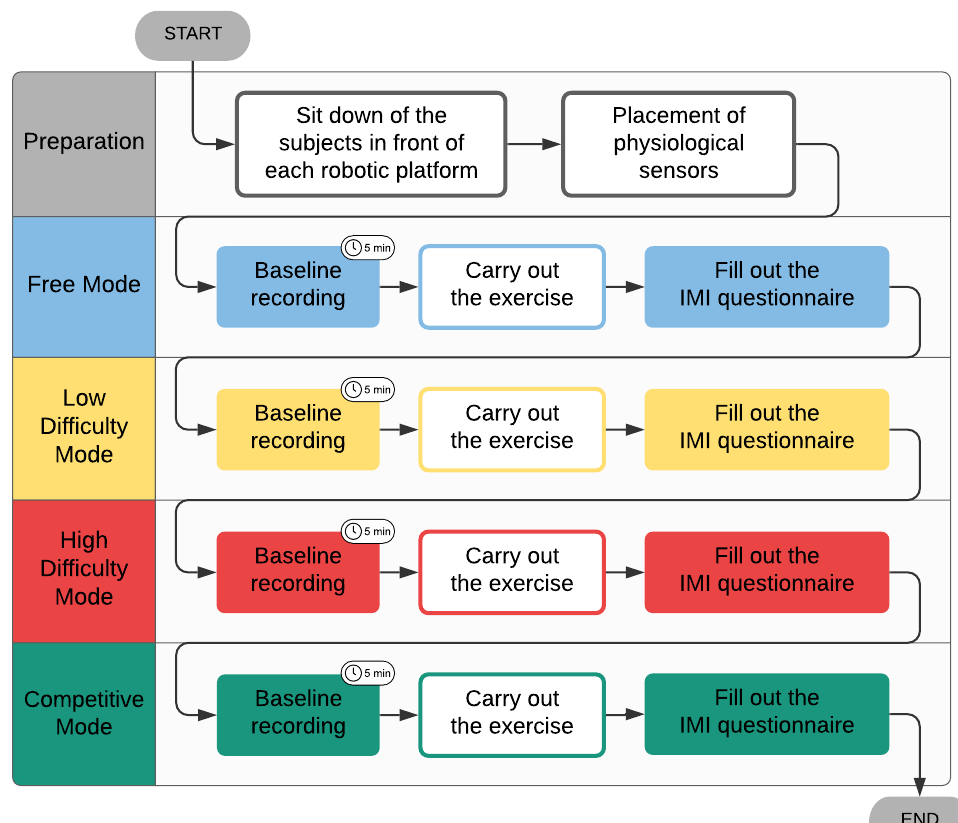
Figure 3. Diagram of the study protocol. The conditions were performed sequentially. Before each condition, a baseline recording period of 5 min was carried